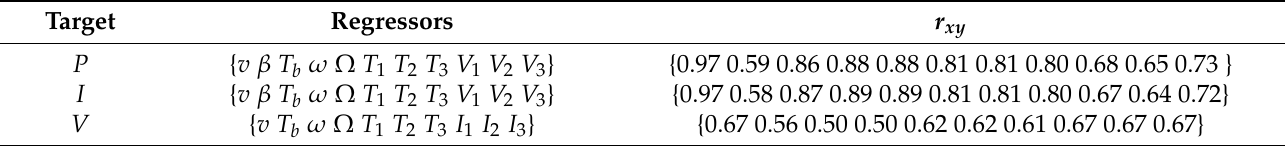
Table 5. Correlation coefficients r xy for the target turbine after the replacement of the